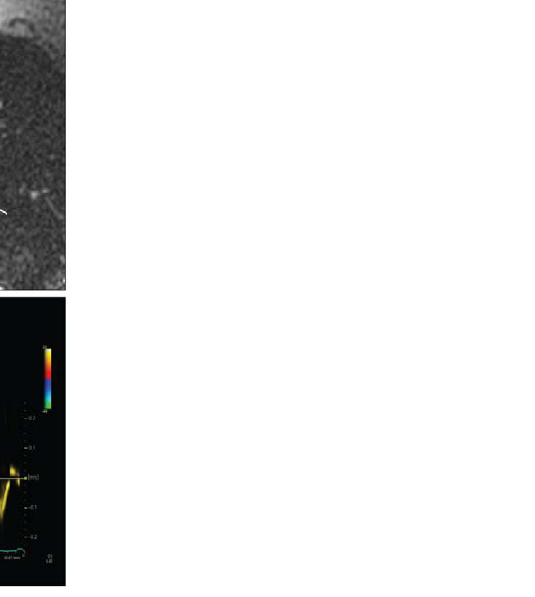
Figure 2. Example of a patient in the undetermined form of Chagas disease with delayed enhancement on cardiac magnetic resonance and abnormal diastolic function. Short axis delayed enhanced CMR images (panels A & B) showing focal linear hyperenhancement in the basal inferolateral segment (red arrows). Panels C and D depict Doppler mitral inflow and myocardial tissue velocity imaging pattern consistent with impaired diastolic dysfunction in the same patient.